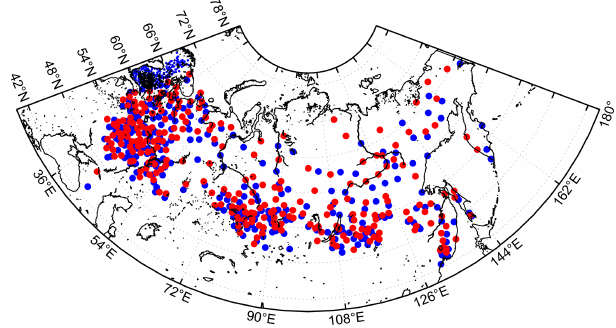
Figure 3. Average snow density and SWE versus DOW for snow transect in western Russia with latitude 59.4 ◦ N and longitude 33.1 ◦ E using multi-decadal data. Blue asterisks show average den- sity calculated for each DOW separately. Red square markers show average densities calculated using data for two consecutive days if available. The red dashed line shows averaged SWE for the same